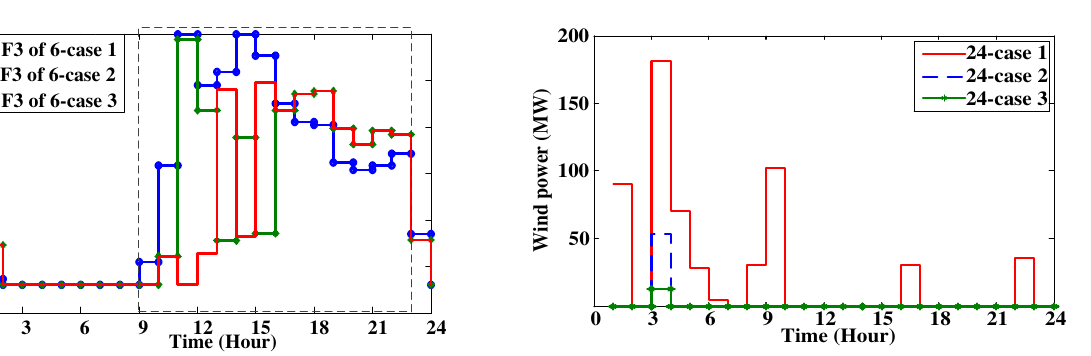
Fig. 9 Comparisons of the output of F3